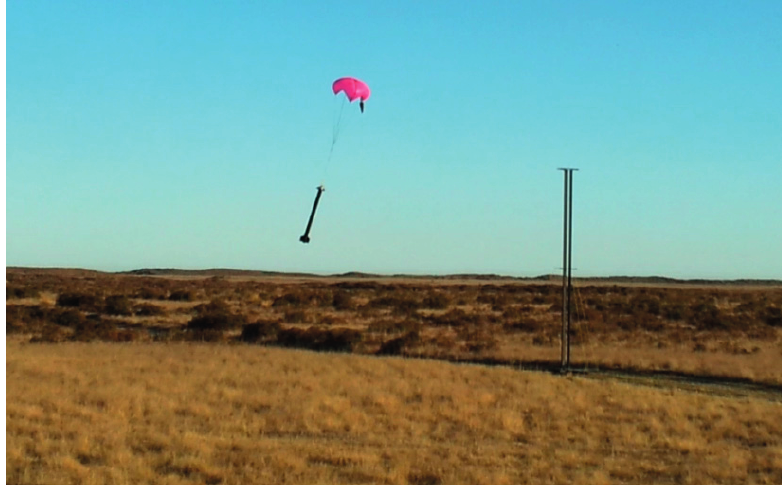
Figure 7. An earlier rocket (Lisa III) coming down under